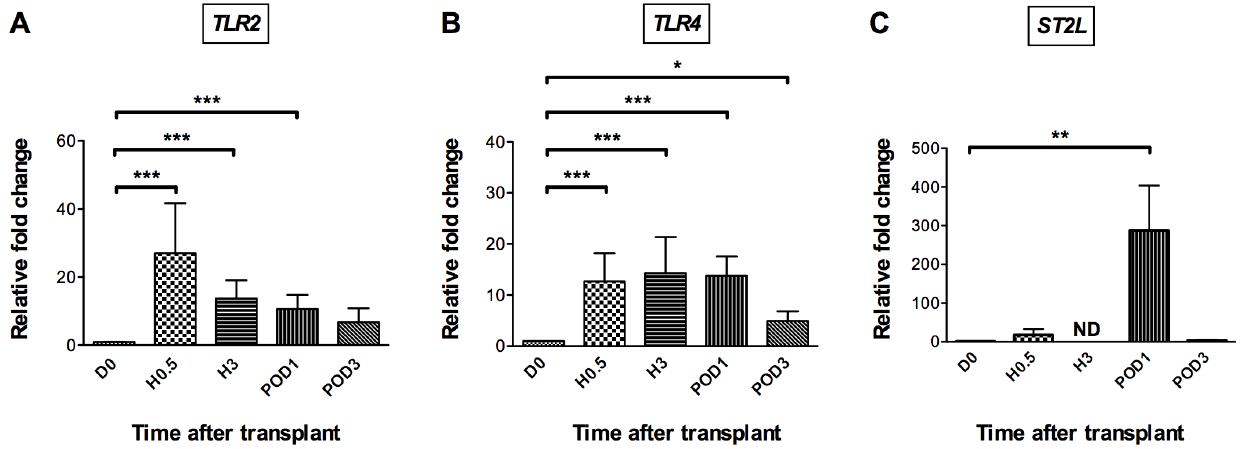
Figure 3. Up-regulation of alarmin-receptor mRNAs in leucocytes after renal IRI. Patient peripheral blood was recovered before transplantation (D0) as control time, and 30 minutes (H0.5), 3 hours (H3), day 1 (POD1) and day 3 (POD3) after transplantation. Total RNA was extracted from leucocytes at the indicated time points and expression of TLR2 (n=24) (A), TLR4 (n=25) (B), and ST2L (n=14) (C) mRNAs was quantified by RT-qPCR. Results are expressed as means 6 SEM of fold change relative to D0. *p , 0.05, **p , 0.01, ***p , 0.001 vs D0 by Wilcoxon test. ND: not done.